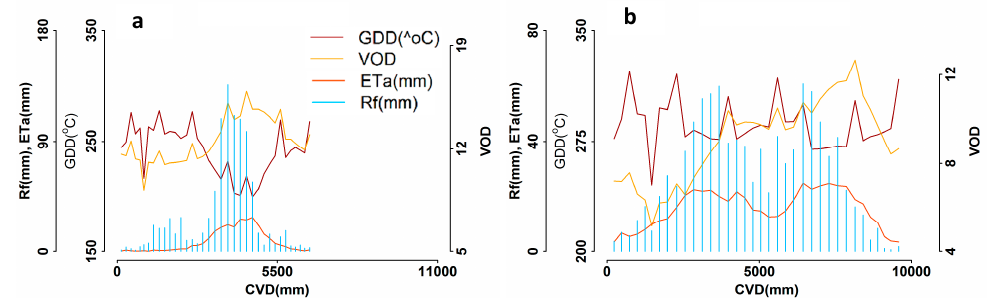
Figure 9. Time series of MODIS rainfall, SSEB ETa, and AMSR GDD and VOD for ( a ) #87 in Ethiopia and ( b ) #14 in Tanzania for 2003–2015.